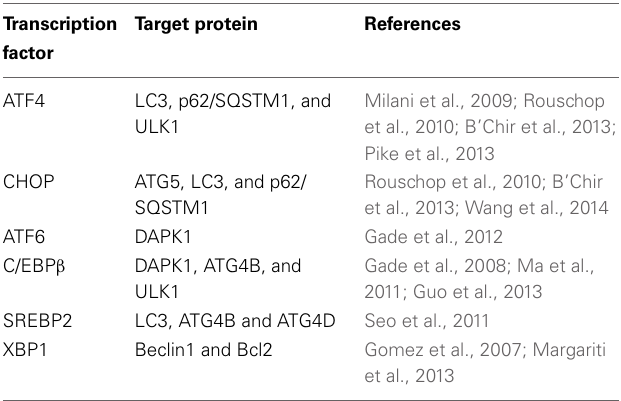
Table 1 | Exploitation of autophagy by modulation of UPR transcription factors.